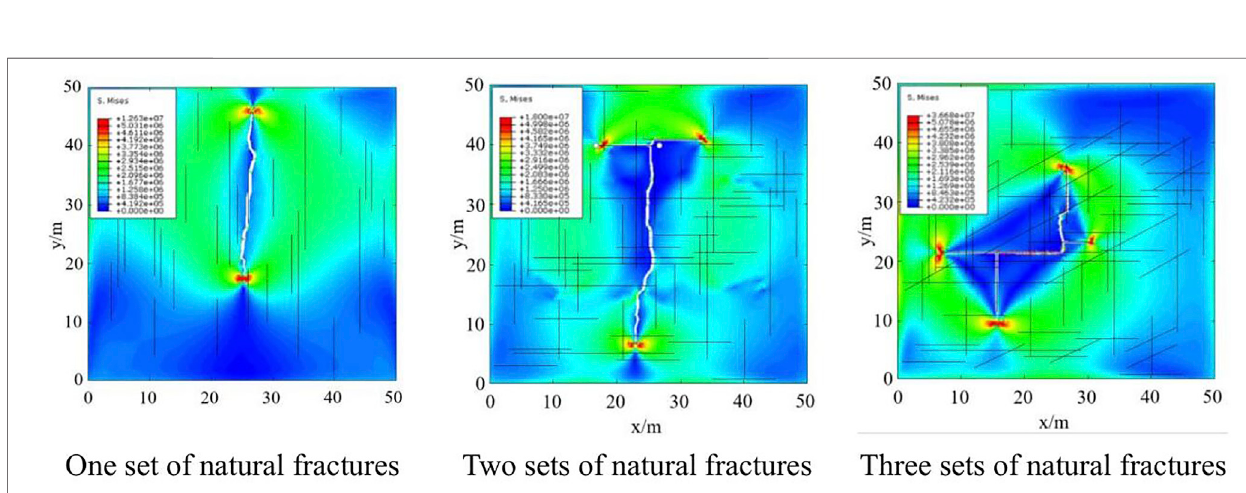
FIGURE9| Hydraulicfracturepropagationpatternofdifferentnaturalfracturegroup.Onesetofnaturalfractures.Twosetsofnaturalfractures.Threesetsofnatural fractures.